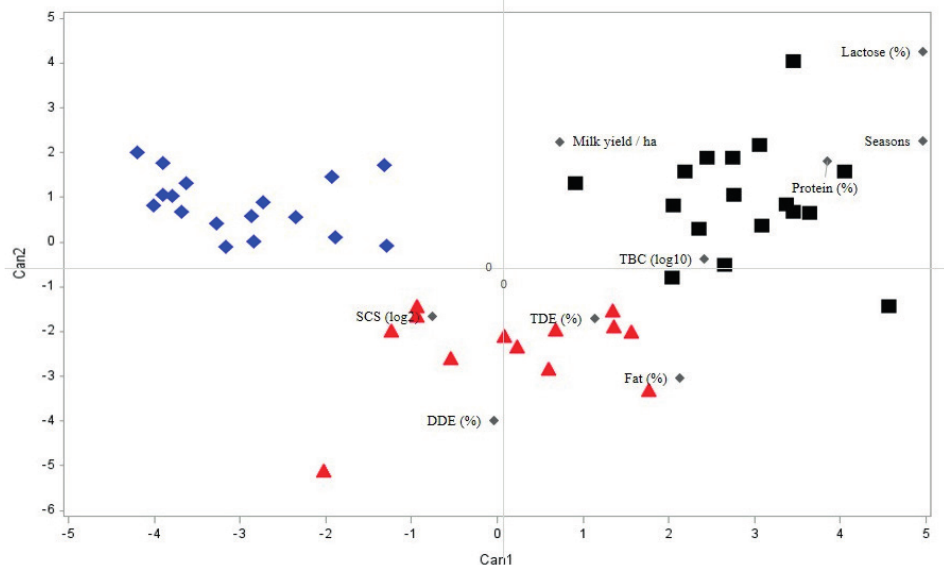
Figure 2 - Discriminant canonical analysis with monthly samples of milk production and composition according to the seasons, microbiological quality of milk and health of the mammary gland. Group 1 (■); Group 2 (▲); Group 3